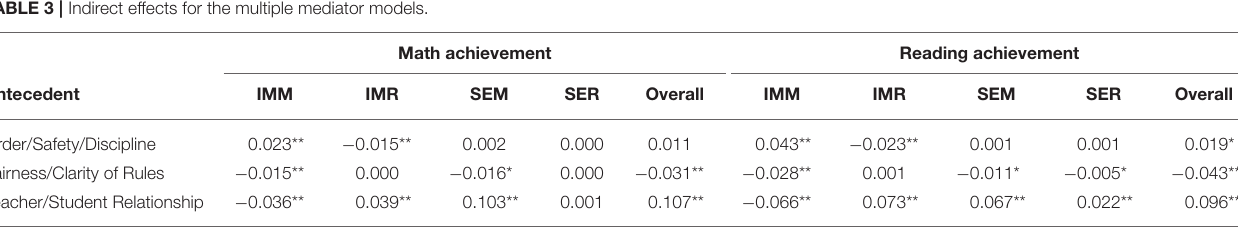
TABLE 3 | Indirect effects for the multiple mediator models. Math achievement Reading